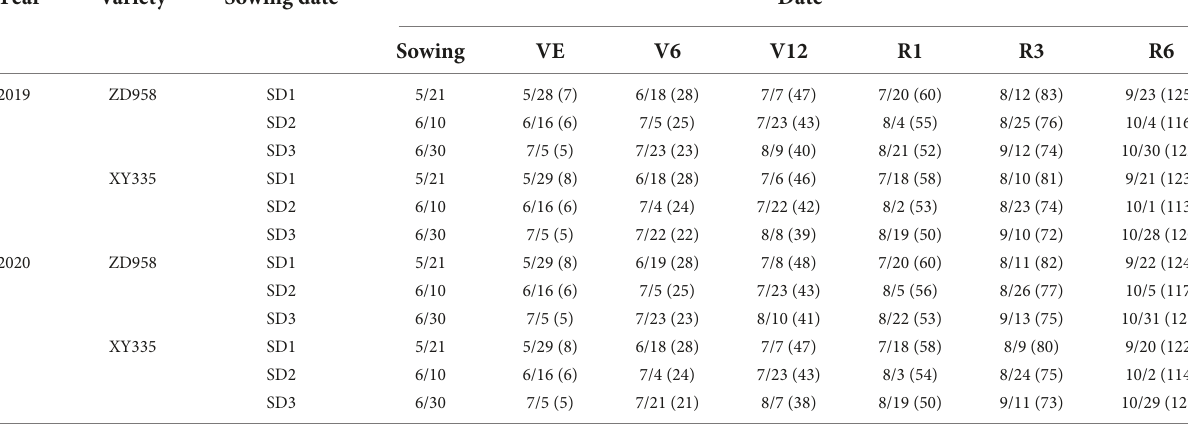
TABLE 2 Dates and days of maize phenology under different sowing dates in 2019 and